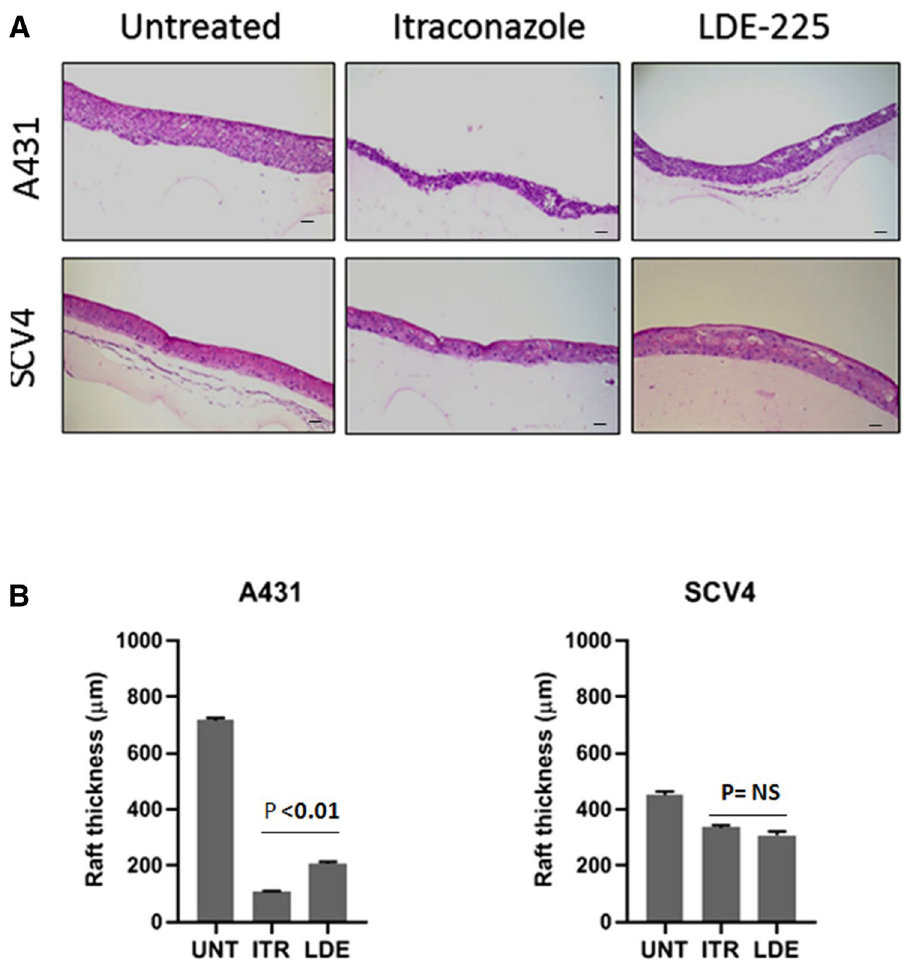
Figure 7. Treatment of Hh-dependent VSCC-derived cell lines in organotypic raft culture with 2.5 µM Itraconazole and 10 µM LDE-225 reduces GLI1 expression and is associated with decreased cell proliferation. ( A ) (upper panels) H&E stained organotypic raft cultures showing a significant reduction in the thickness of epithelium in A431 (Hh-dependent) but not in UM ‐ SCV ‐ 4 (Hh-independent) following seven days treatment with Itraconazole or LDE-225. ( B ) Graphical output depicting the mean raft thickness in control and treated rafts from A431 and UM-SCV4. Data represent the mean from 6 measurements. NS = none significant. ( C , D ) Immunofluorescence staining of control and treated raft culture sections showing reduced expression of GLI1 ( C ) and Ki67 ( D ) in the A431 cell line but not in UM ‐ SCV ‐ 4 following treatment with 2.5 µM Itraconazole (ITR) or 10 µM LDE-225 (LDE). ( E ) Graphical output depicting the mean number of Ki67 positive nuclei in control and treated rafts from A431 and UM-SCV4. Data represent the mean from 3 measurements from 5 independent raft sections. All experiments were performed at least three times. Bar = 50